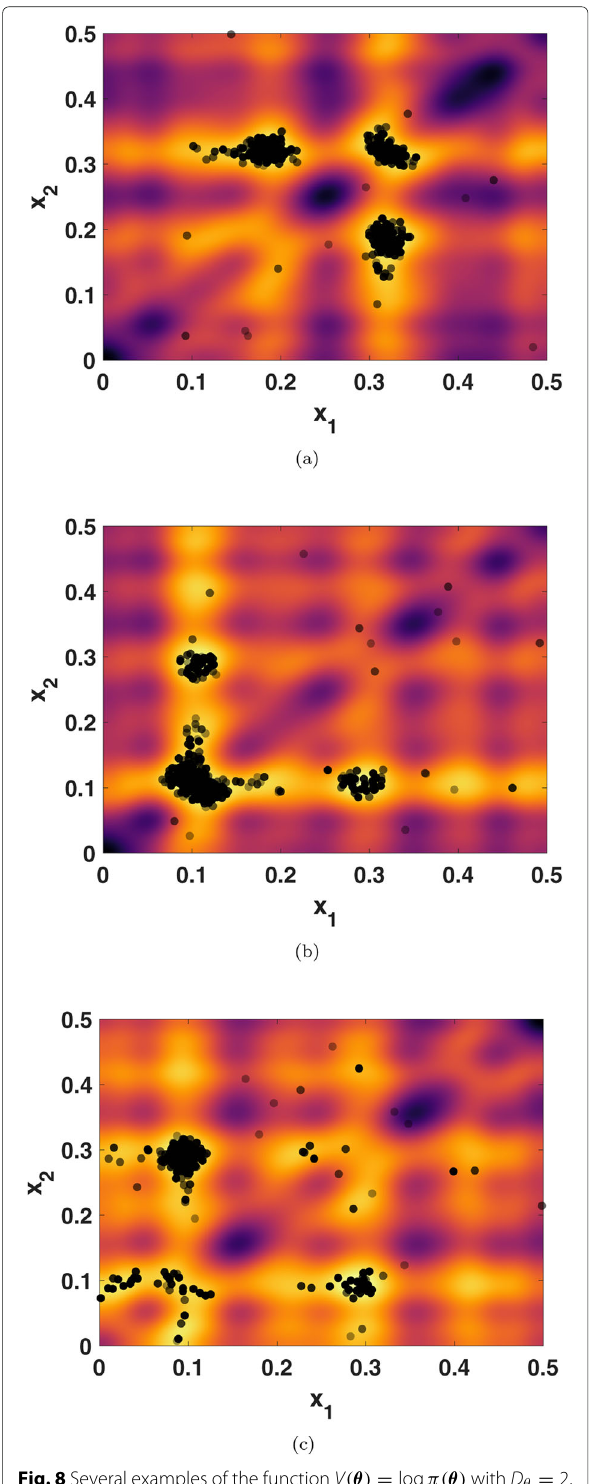
Fig. 9 Relative error (averaged over 500 runs) for OMCMC (solid line) and IPCs (dashed line) with different computational effort E